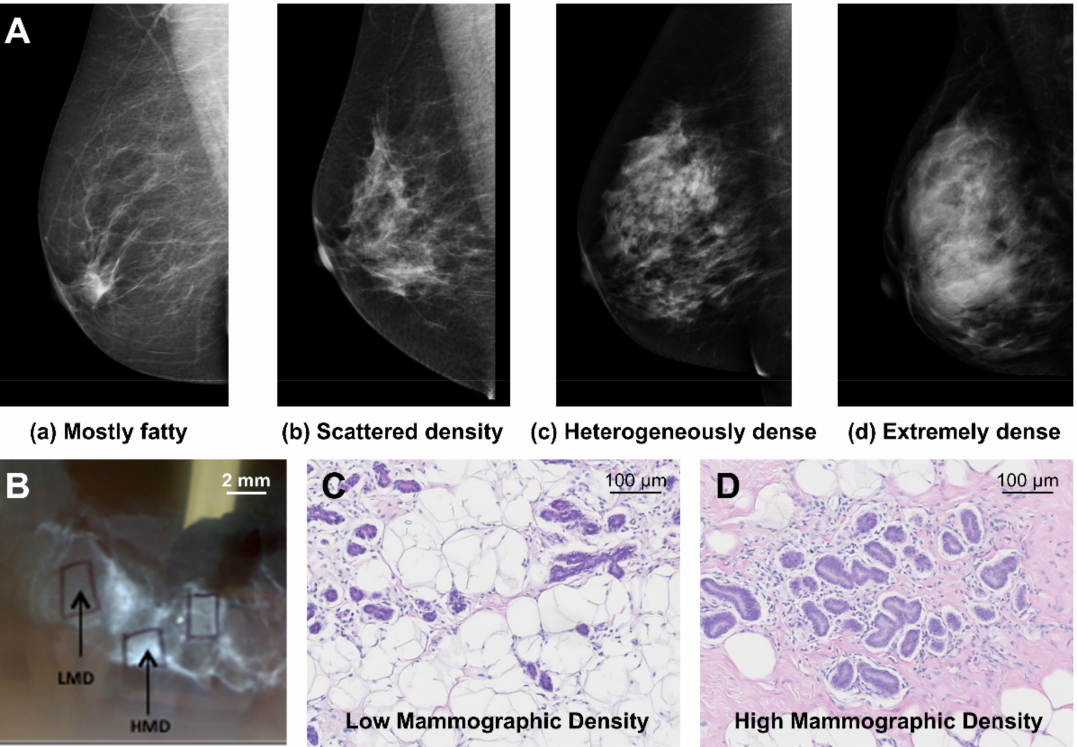
Figure 1. ( A ) Example images of BIRADs classification of mammographic density, ( B ) X-ray of breast tissue demonstrates areas of low and high mammographic density associated with ( C ) more adipose tissue relative to fibro glandular tissue and ( D ) more fibro glandular tissue relative to adipose tissue respectively, when hemotoxylin and eosin stained. Images reproduced with permission from [14] Elsevier and www.informd.org.au (accessed 22 October